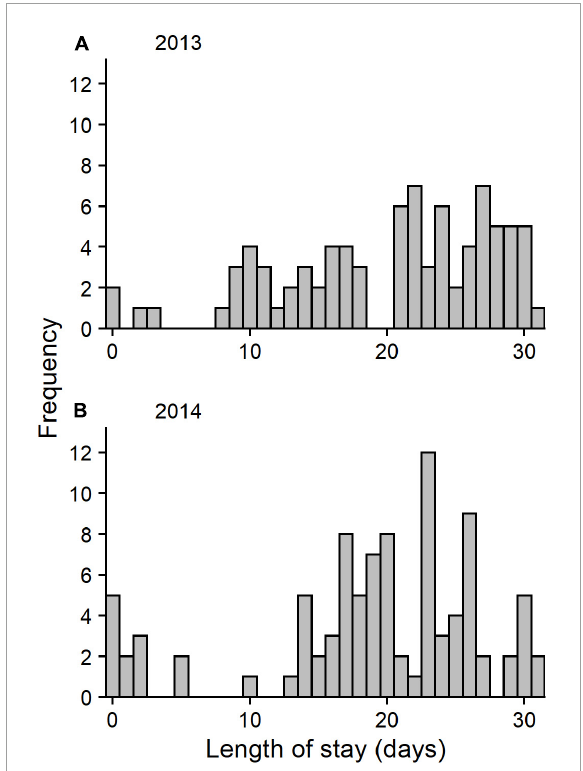
FIGURE2 Distribution of length of stay in (A) 2013 ( N = 85) and (B) 2014 ( N = 94).